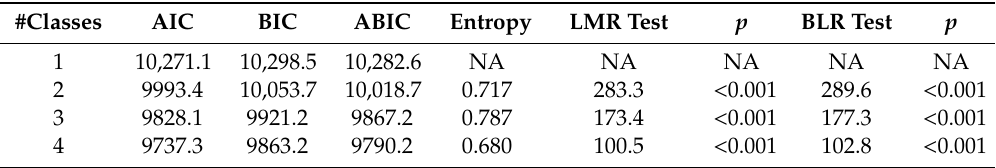
Table 2. Models’ fit for 1 to 4 classes.